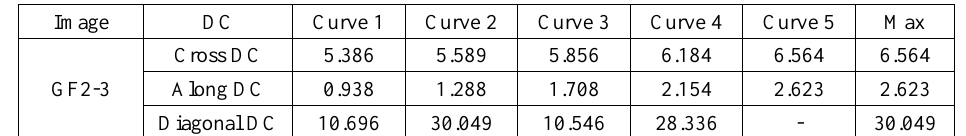
Table 3. The deviation coefficients of the projection trajectories in GF2-3. The deviation coefficients in the table have been multiplied by 10 4 .